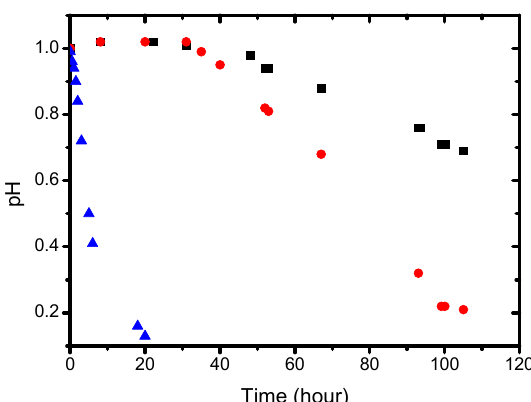
Figure 3. Time dependence of indium concentration in the feed solution for conventional PIM and PIMSD. ( b ) is the replot of the data of ( a ) in log scale, and the small figure in ( b ) is the magnification of the concentration change in the first 360 min. ▼ : conventional PIM with 1 M HCl as the strip Figure 9. Time dependence of the solution pH in the feed cell. (cid:4) : conventional PIM with 1 M HCl as Figure 9. Time dependence of the solution pH in the feed cell. ￭ : conventional PIM with 1 M HCl as the strip solution; solution; ￭ conventional PIM with 5 M HCl as the strip solution; ● : PIMSD with 5 M HCl as the strip the strip solution; ● : conventional PIM with 2 M HCl as the strip solution; ▲ : conventional PIM with 5 M HCl as the strip solution.